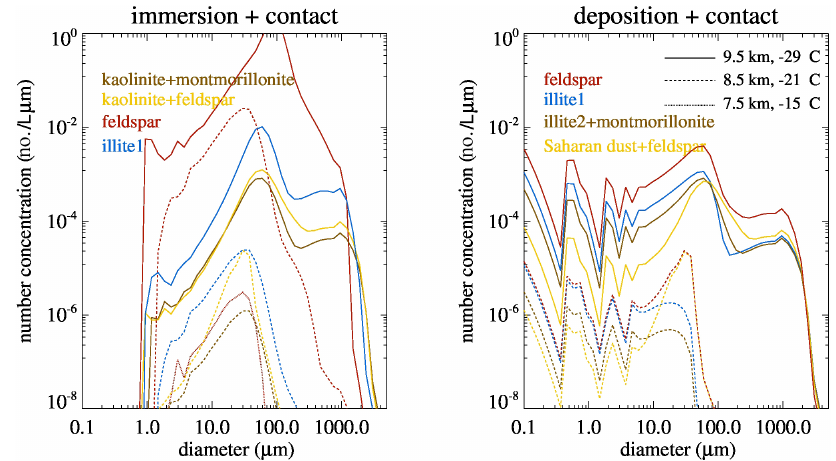
Figure 11. Development of ice particle numbers with altitude and corresponding temperature, marked by different line styles, for coupled freezing processes. Types of INP marked by colors. Model simulations with average continental number size distribution, and with (cid:49)T = 2K. Number concentrations per L and µm as a function of particle diameter.